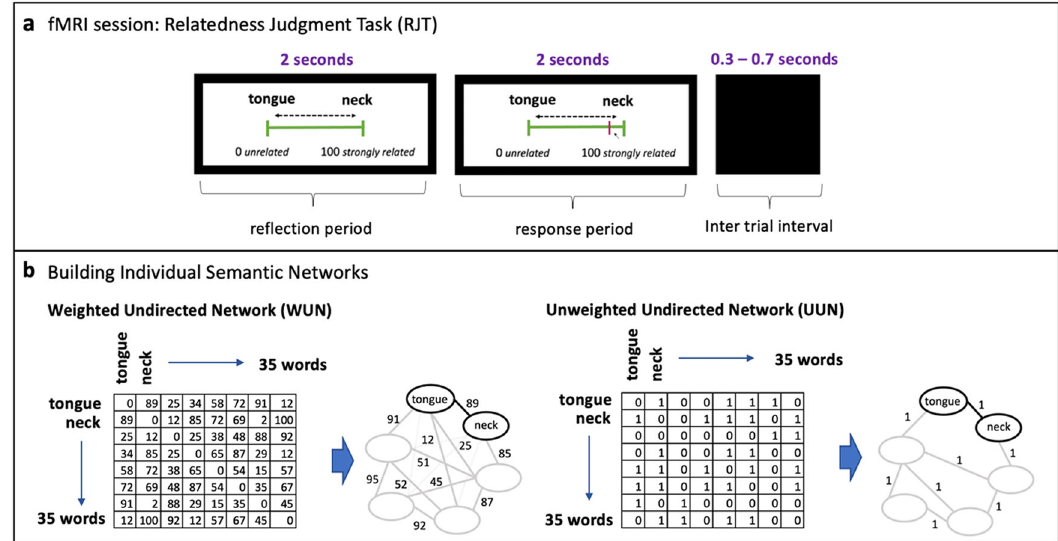
Fig. 2 Building of individual semantic networks (SemNets) from the RJT. a In each RJT trial, participants judged the relatedness of 595 word pairs. During the re fl ection period, participants thought about the relationships between the different pairs of words. In the response period, participants moved the cursor (in magenta) using a visual scale ranging from 0 (unrelated words) to 100 (strongly related words) to indicate the relatedness of the two words. A jittered inter-trial interval separated trials. b Using the ratings of all the RJT trials, we computed a 35 by 35 adjacency matrix for each participant with rows and columns representing the words of the task. For the weighted undirected networks (WUN), cell values correspond to the relatedness judgments given by the participant during the RJT. For the unweighted undirected network (UUN), cell values correspond to a binary value of 1 for judgments above or equal to 50, and 0 for judgments below 50. From these adjacency matrices, we built the WUN and UUN graphs and estimated their SemNet metrics 24,27